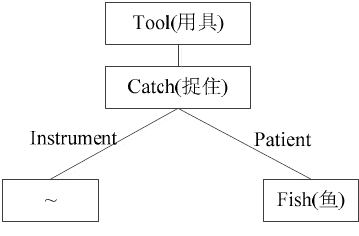
Figure 3. Hierarchy of fishing pole DEF.